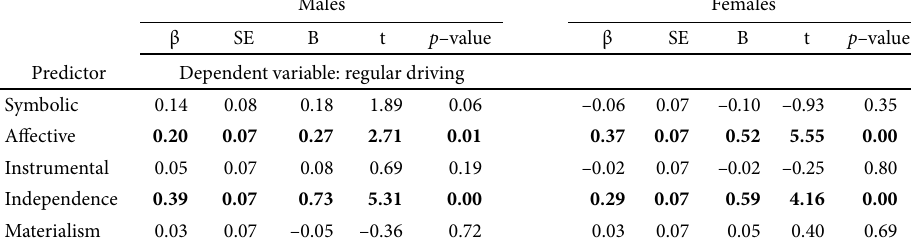
Predictor Dependent variable: cars and driving liking